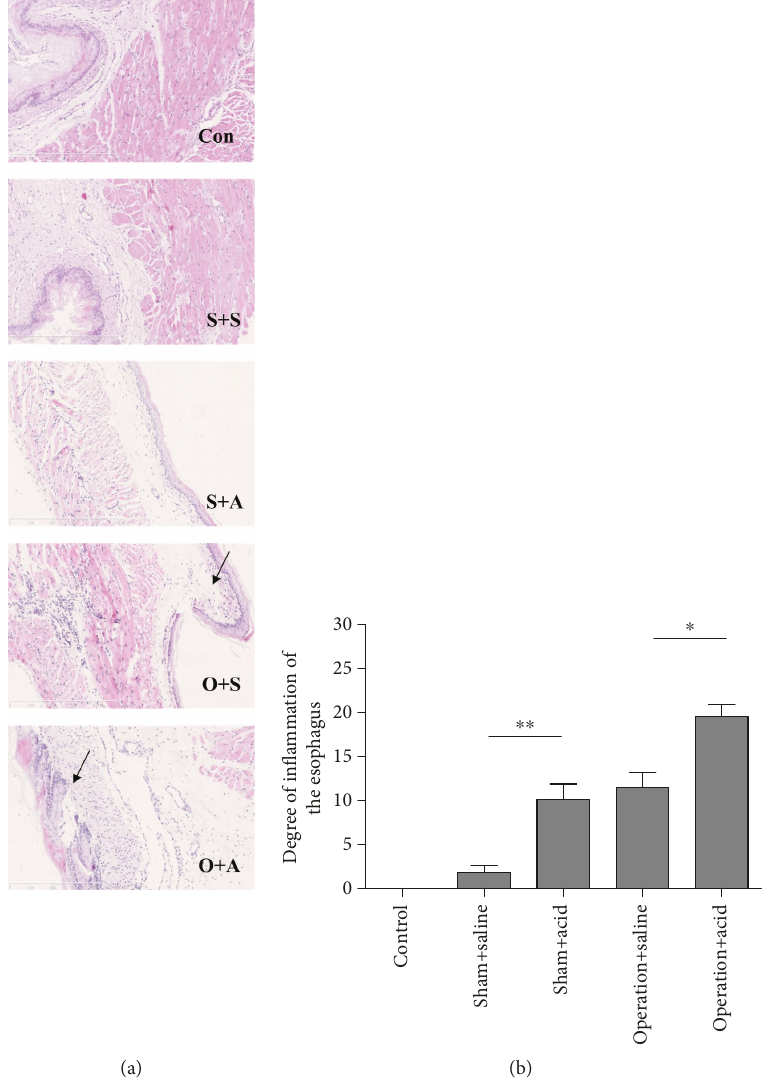
Figure 3: Esophageal instillation and DMV destruction led to severe esophageal tissue damage in rats. (a) HE staining of the lower esophagus in the control group (Con), sham + saline group (S+S), sham + acid group (S+A), operation + saline group (O+S), and operation + acid group (O+A). Arrows shows submucosal edema. (b) The esophageal tissue damage scores under the light microscope in rats in the acute esophagitis model induced by esophageal instillation and DMV destruction ( n = 8 , ∗ P < 0 05 and ∗∗ P < 0 01 ). The microscopic esophagitis scores in the lower esophageal segment were signi fi cantly higher in the sham + acid group than in the sham + saline group ( 1 83 ± 0 75 ) ( P < 0 01 ). No signi fi cant di ff erence in the microscopic esophagitis scores was observed between the operation + saline group ( 11 5 ± 1 69 ) and the sham + acid group ( 10 13 ± 1 73 ) ( P > 0 05 ). The microscopic esophagitis scores were higher in the lower esophageal segment of the operation + acid group ( 19 5 ± 1 41 ) than in the operation + saline group ( P < 0 05